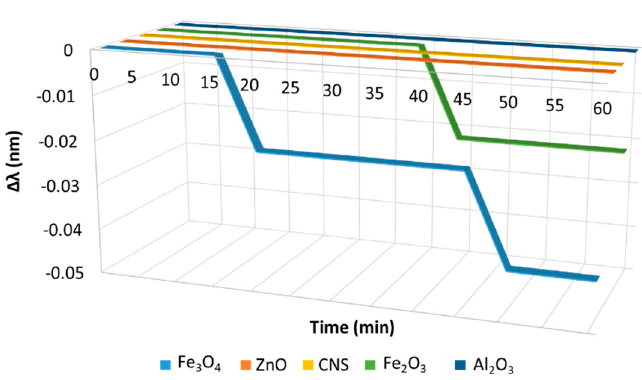
Figure 7. Wavelength changes over time during Fe 3 O 4 , Fe 2 O 3 , ZnO, Al 2 O 3 , and CNS injection.